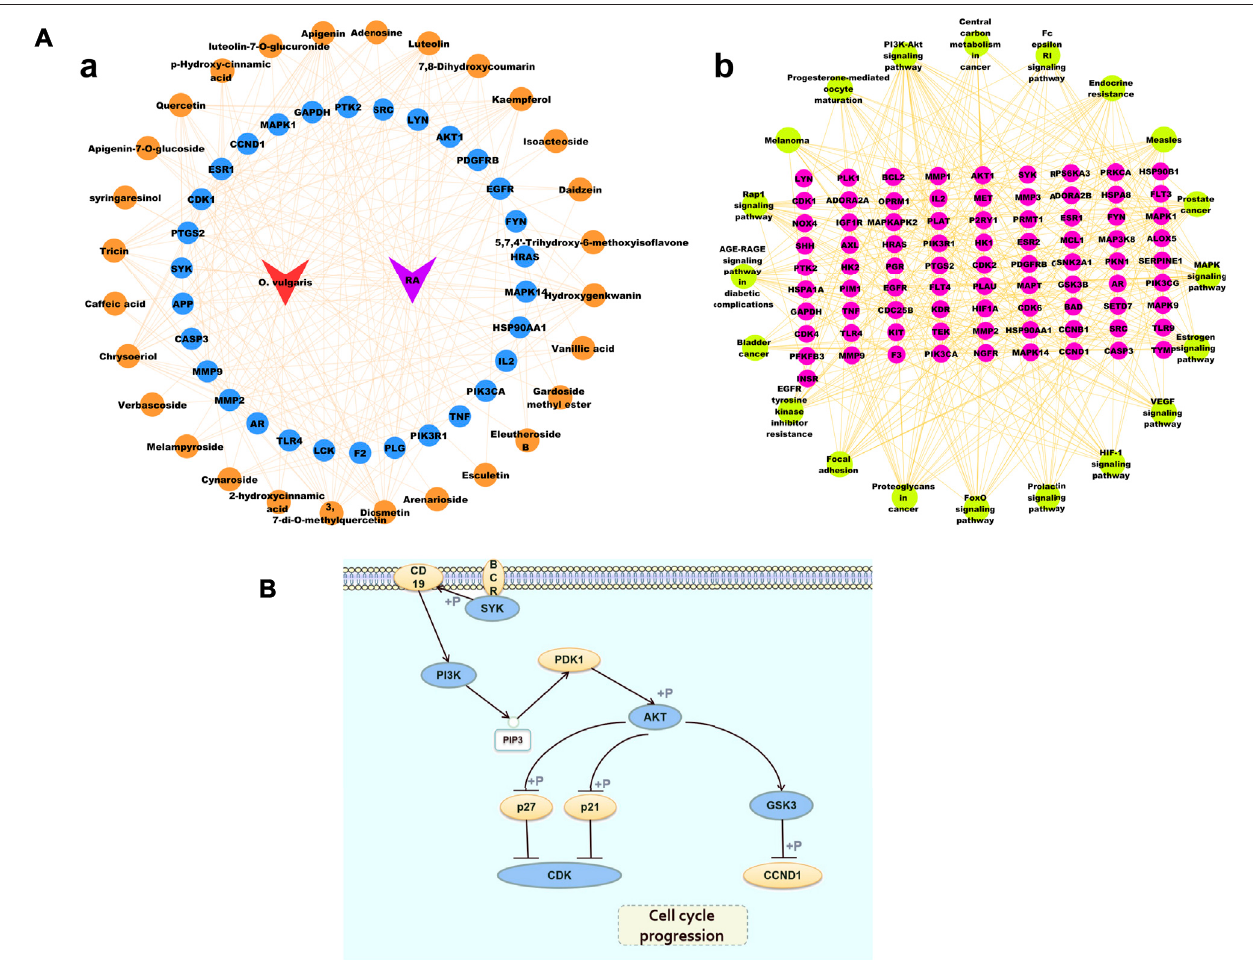
FIGURE 8 | (A) Cytoscape Network diagram [ (Aa) . Compound-Target diagram; (Ab) . Target-Pathway Diagram]; (B) PI3K-Akt signaling pathway.